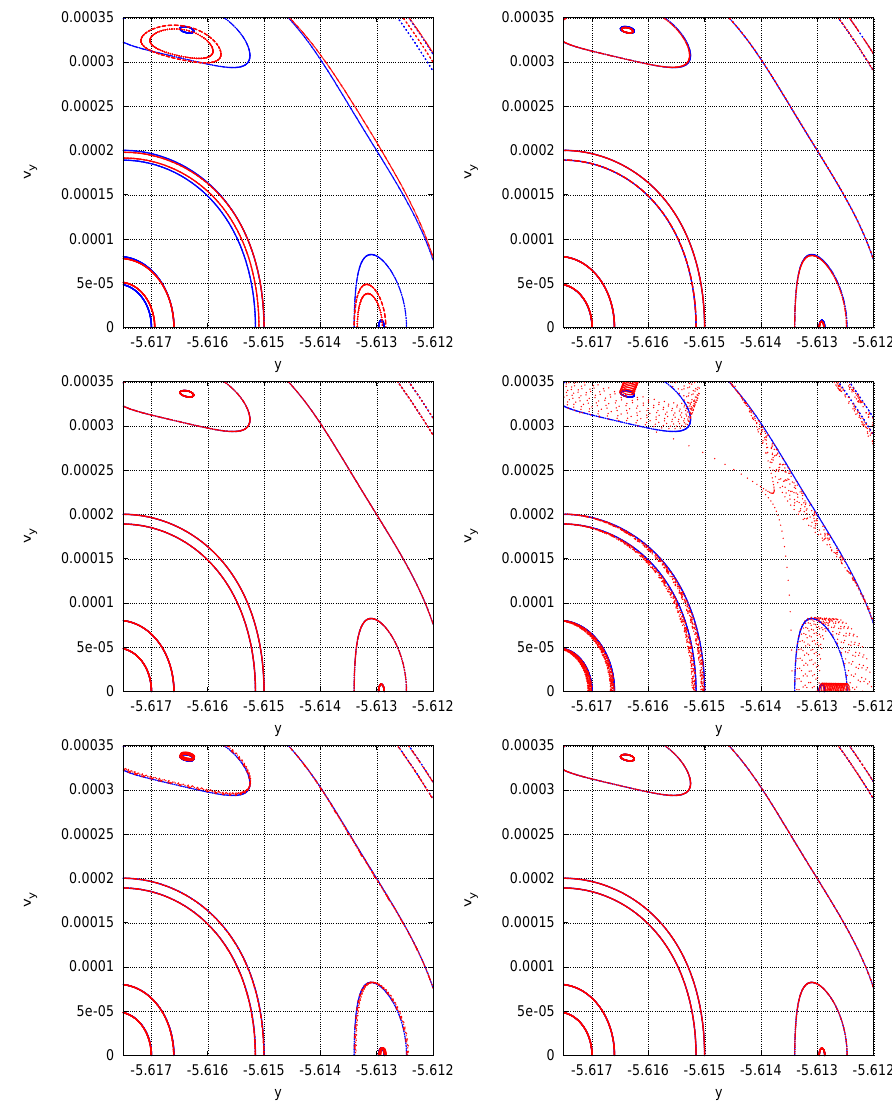
Fig. 18. A detail from Poincar´e maps produced by the SYMP and RK78 methods (red) overlaid on the truth model (blue). From left to right and top to bottom, the data are from runs 12, 9, and 7 of the SYMP method, and 13, 10 and 7 of the RK78